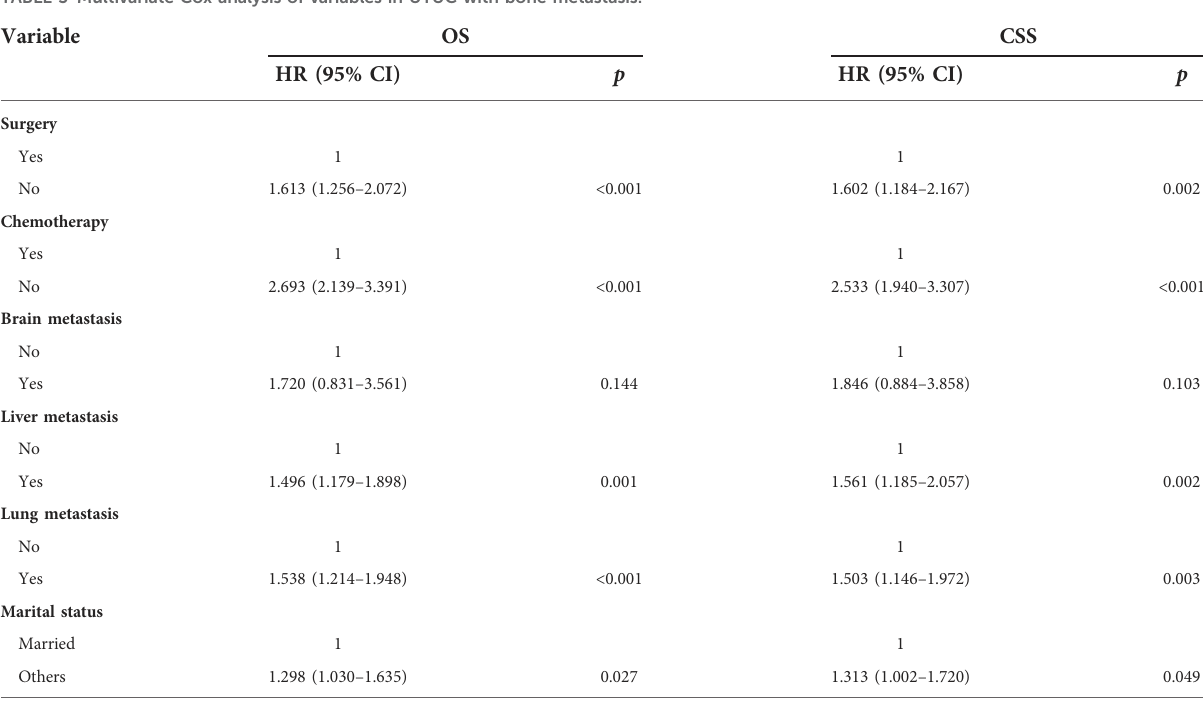
TABLE 3 Multivariate Cox analysis of variables in UTUC with bone